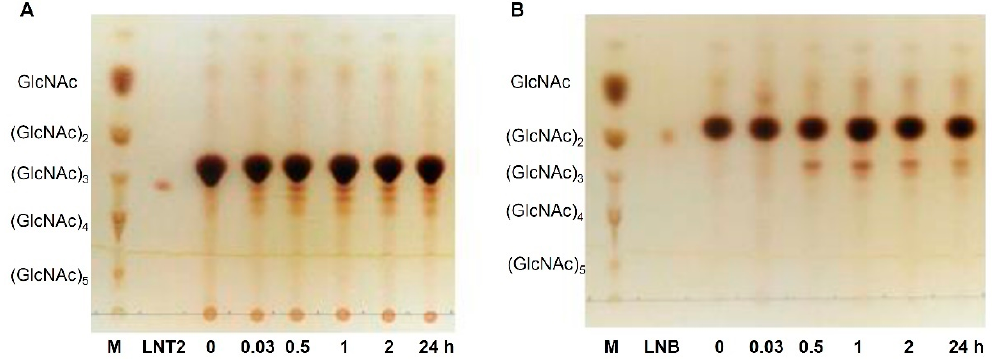
Figure 7. Time course of transglycosylation by Ph Nah20A (10 U · mL − 1 ) with 100 mM NAG-oxazoline as donor and either 200 mM lactose ( A ) or d -galactose ( B ) as acceptor (see Section 3.8 for details). Chitooligosaccharides (M), lacto- N -triose II (LNT2) and lacto- N -biose (LNB) were used as references.